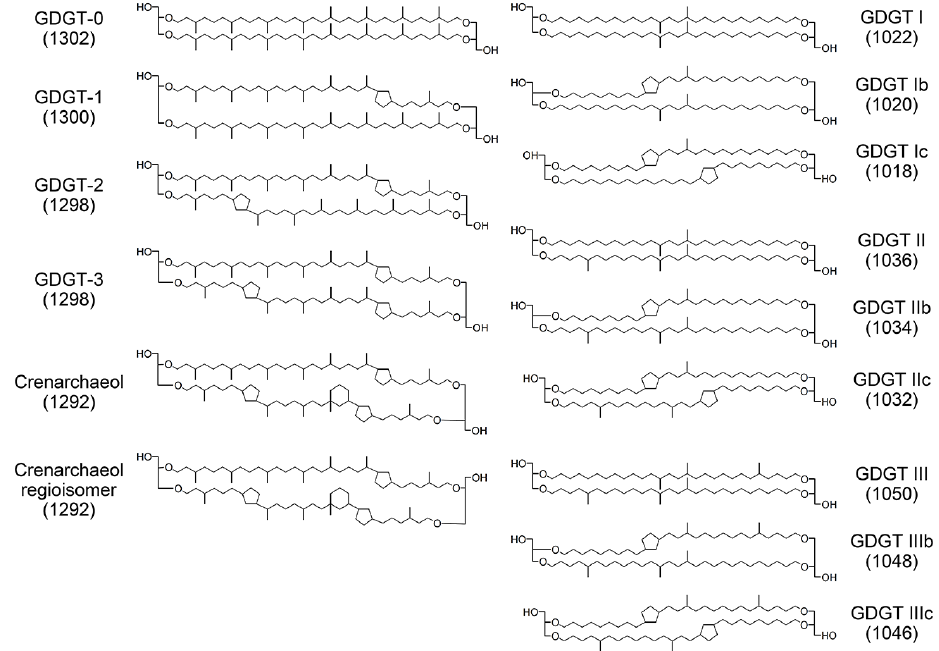
Figure A1. Structures of isoprenoid and branched